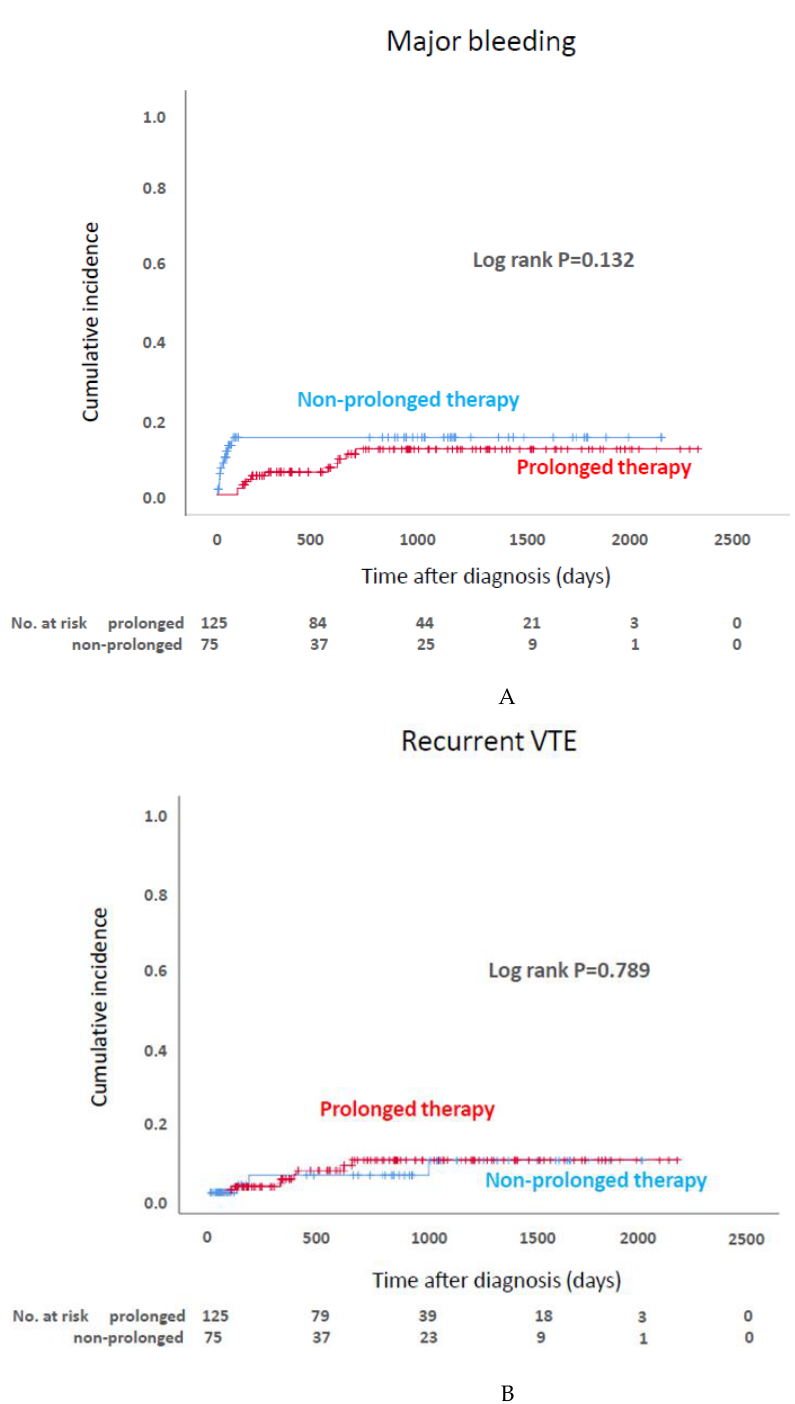
Figure 3. Kaplan–Meier curves estimating incidence of major bleeding ( A ) and recurrent venous thromboembolism ( B ) between patients who received prolonged and nonprolonged